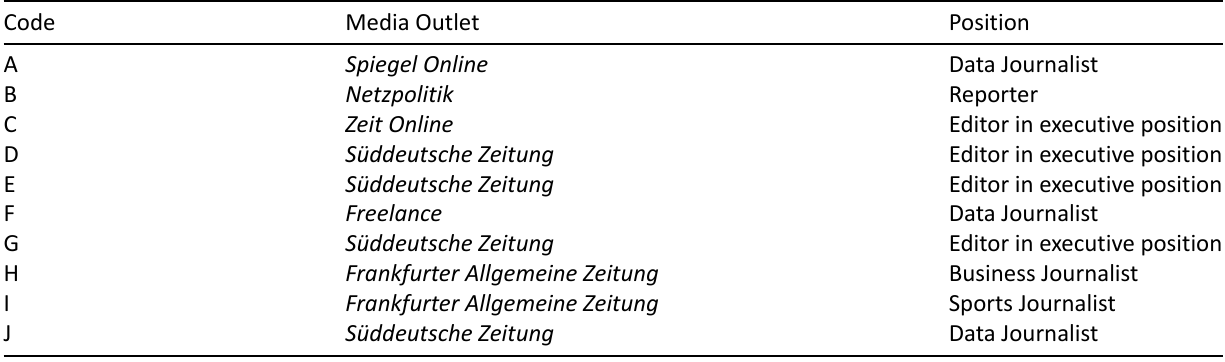
Table 1. Sample of interviewees including media outlet and position